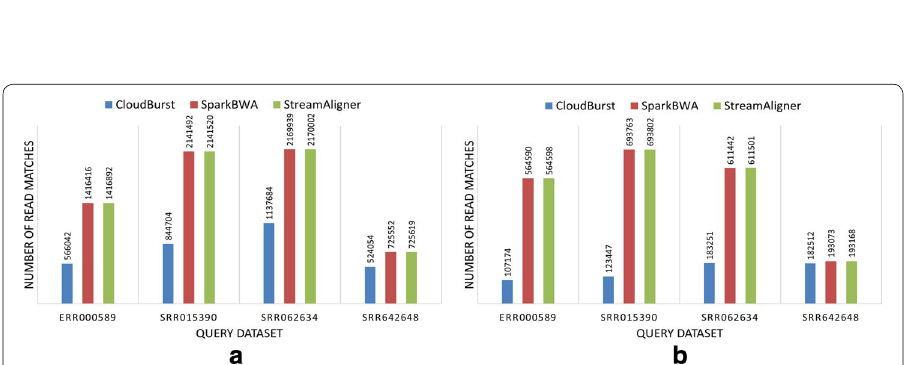
Fig. 11 StreamAligner accuracy evaluation to map different query datasets on ( a ) Chr1 and ( b )